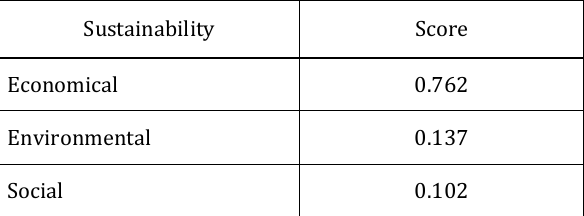
Table 7. Sustainability score from the sugar industry Sustainability Score Economical 0.762 Environmental 0.137 Social